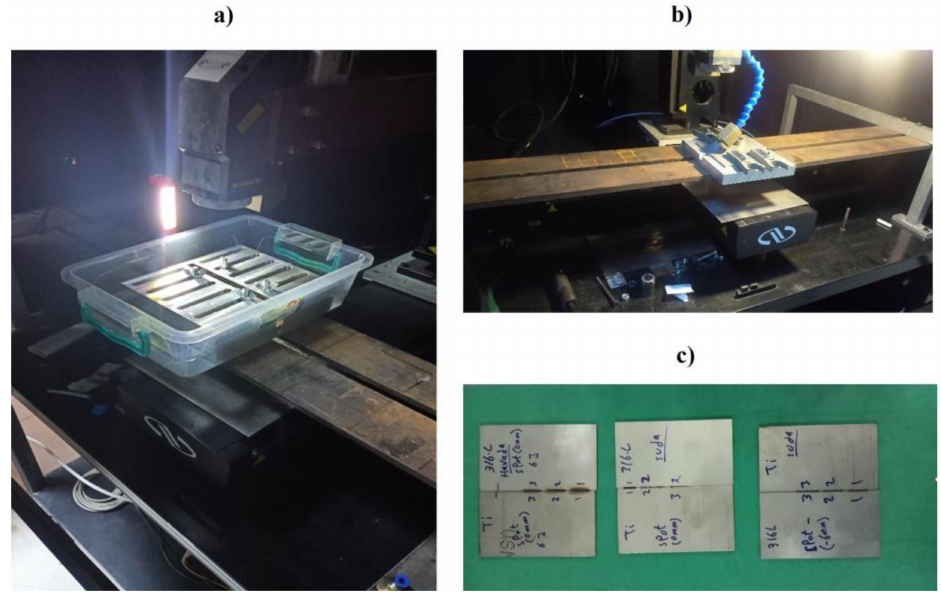
Figure 3. The photographs of ( a ) the experimental setup, ( b ) the welded plate, and ( c ) the samples prepared from the welded